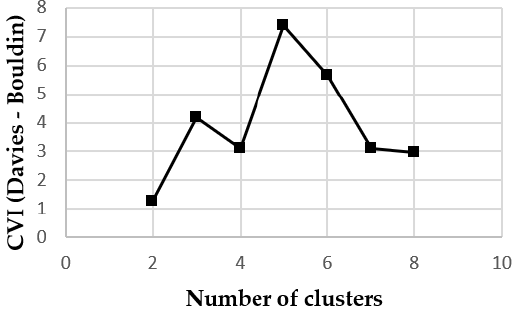
Figure 9. CVI (Davies-Bouldin). The generated clusters of the catchments are further classified according to the po- tential risks of the occurrence of rapid runoff. In terms of the effect of the parameters on the risks associated with the rapid occurrence of runoff, the following holds for individual